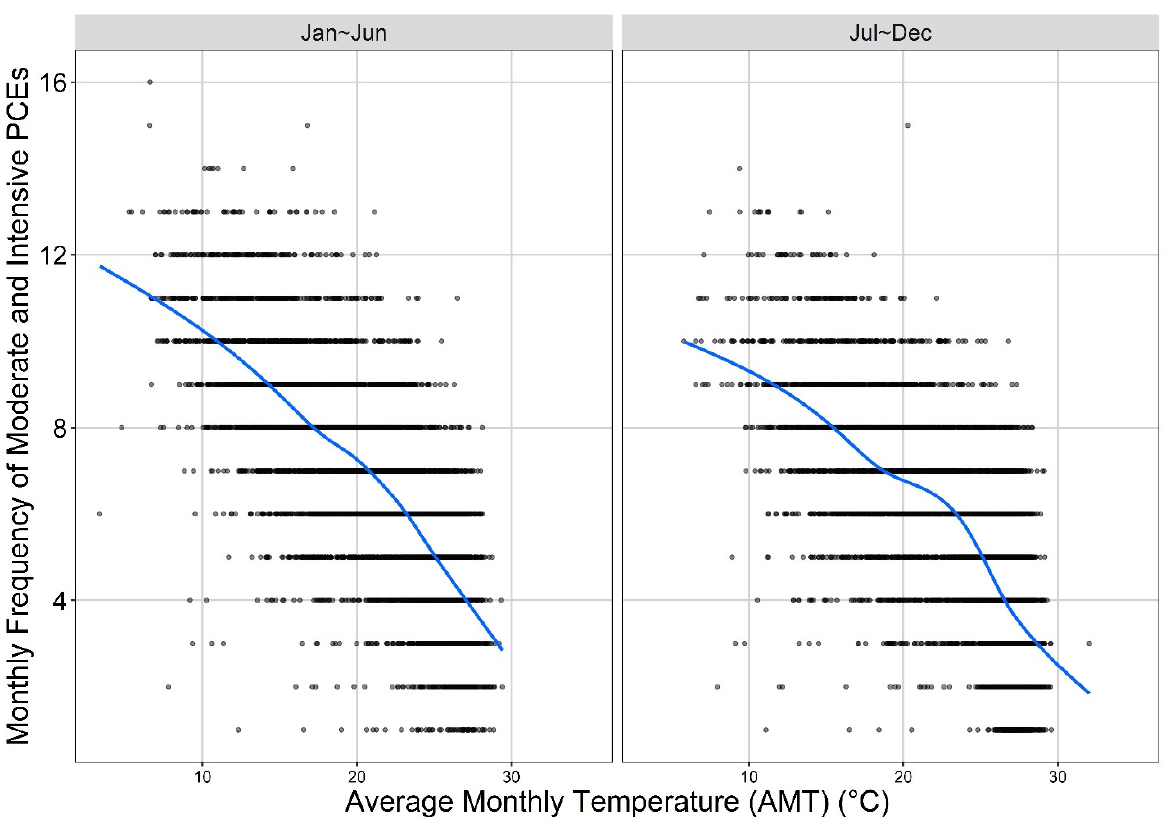
Figure 4. Association between monthly pressure change event (PCE) frequency and average monthly temperature (AMT) in local regression (blue lines).